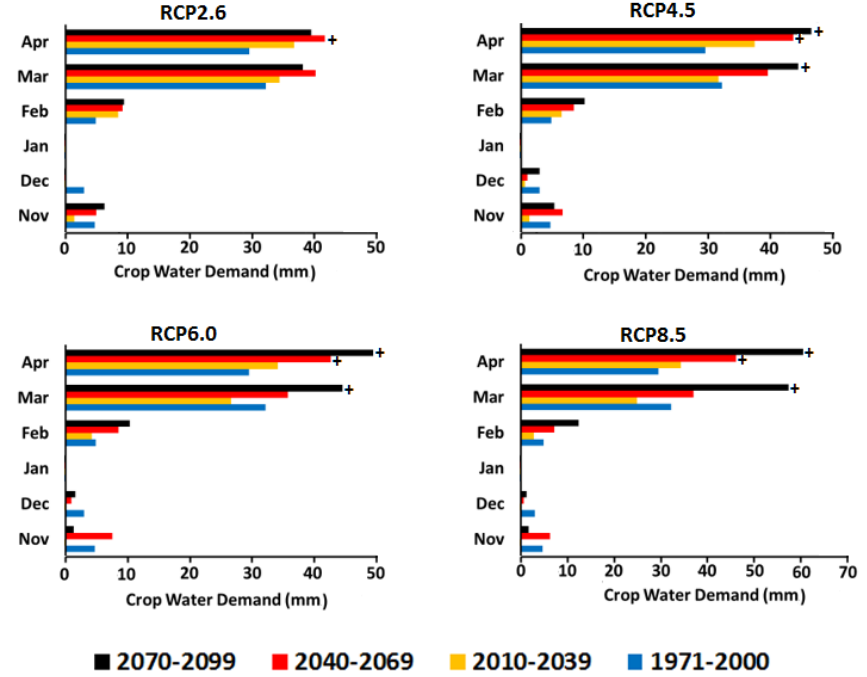
Figure 10. Wheat CWD in the different months of the crop season during 2010–2039 (yellow), 2040– 2069 (red), and 2070–2099 (black) and the base year 1961–1990 (blue) and (+) indicates significant change at p < 0.05.